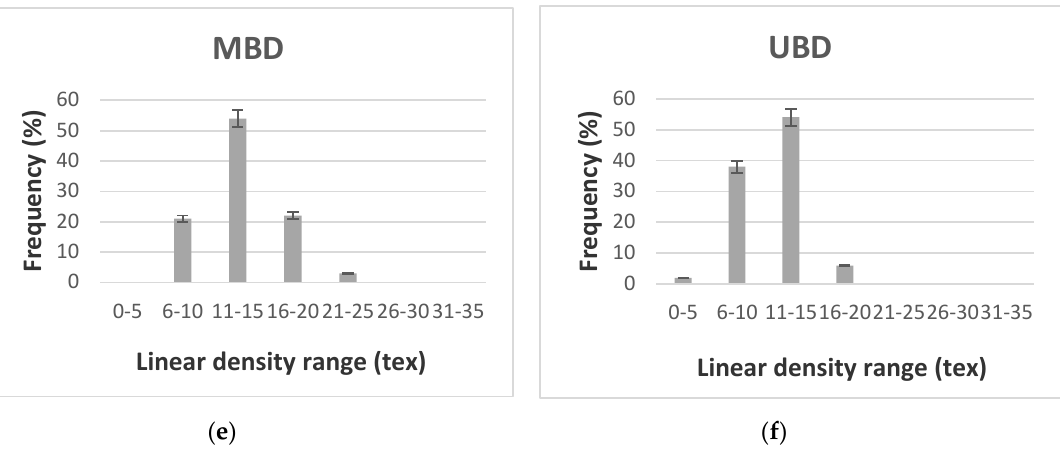
Figure 4. Linear density histograms of ( a ) BBW, ( b ) MBW, ( c ) UBW, ( d ) BBD, ( e ) MBD and ( f ) UBD fibers.